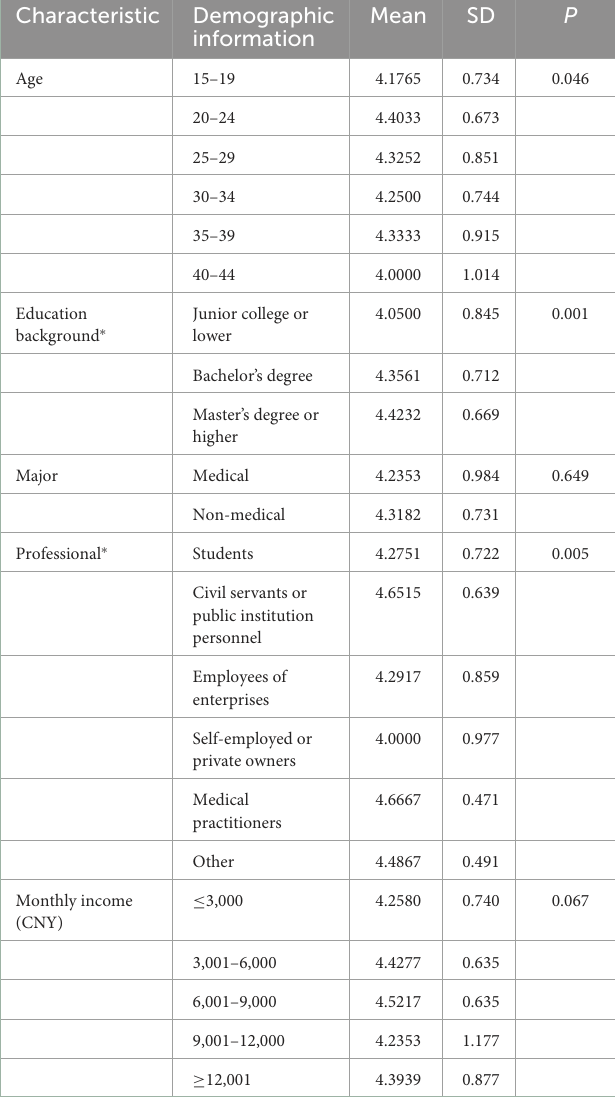
TABLE 2 Differential testing of demographic characteristics in intention to receive the HPV vaccine ( N = 567).